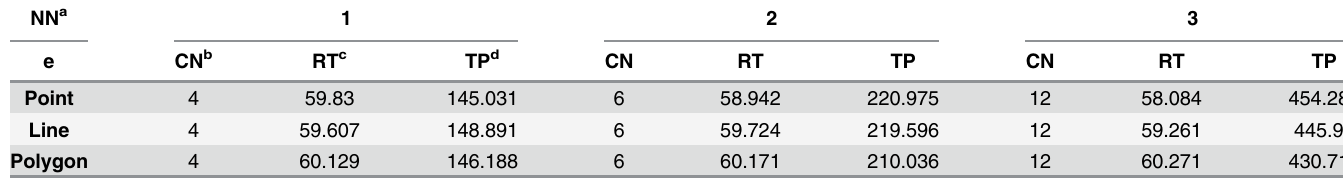
Table 3. Performance test of different clusters for polygon clip operation in batch